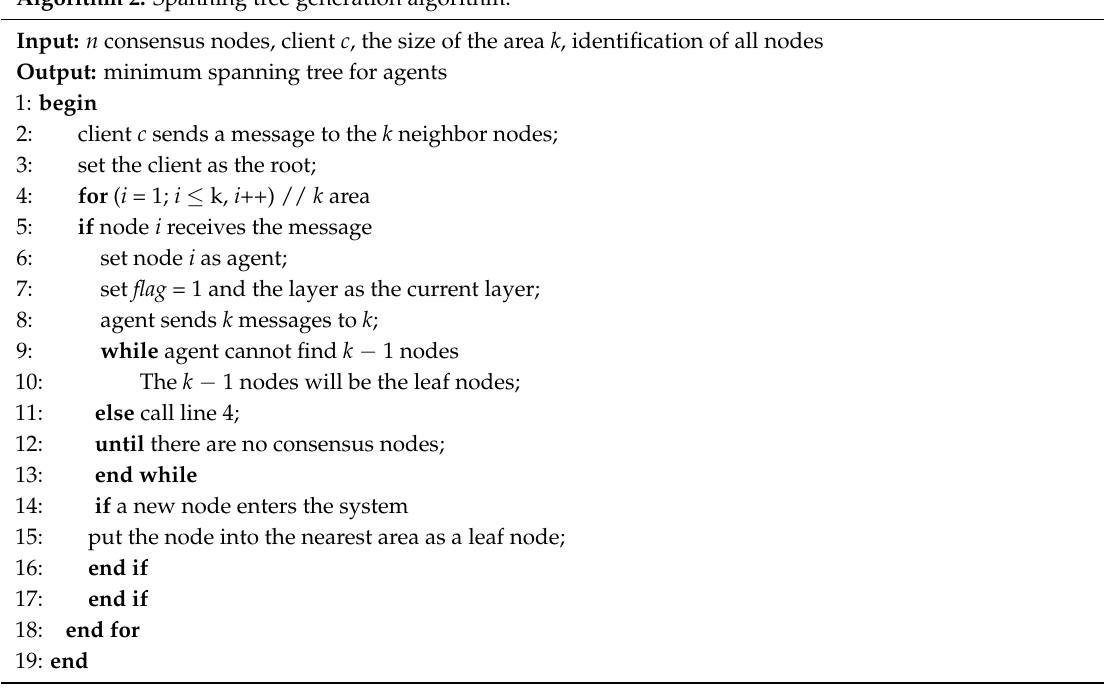
Figure 4. Spanning tree that is generated for multicasting.